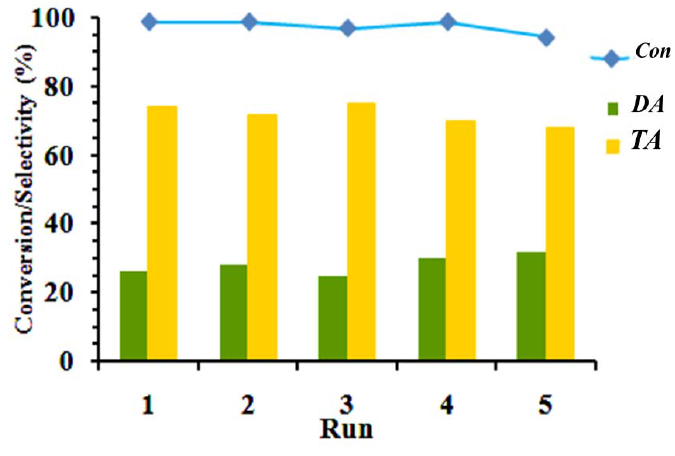
Figure 5. Recycling of AS ‐ BEN at reaction conditions: AA/Gly = 7, 3 h, 100 °C.